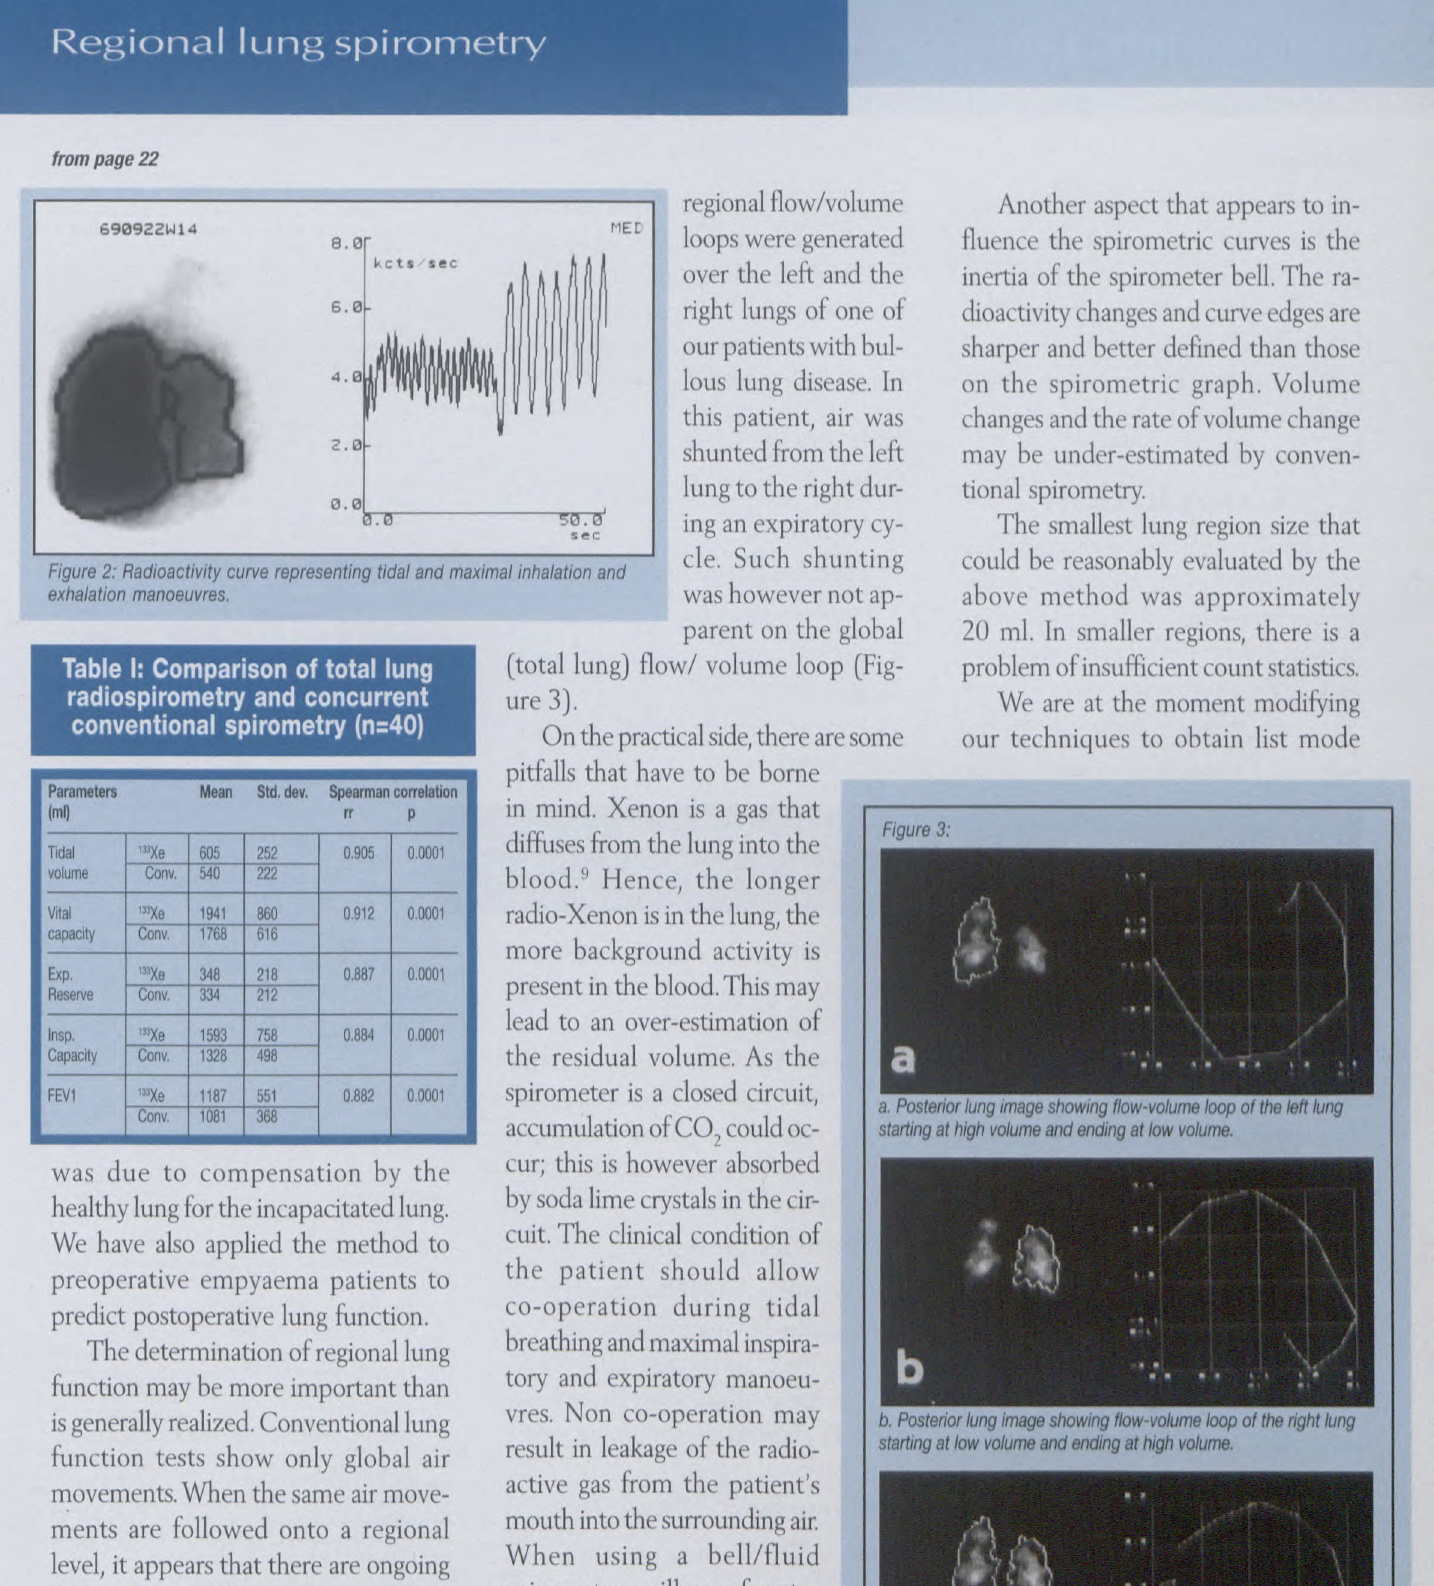
Figure 2: Radioactivity curve representing tidal and maximal inhalation and exhalation manoeuvres.